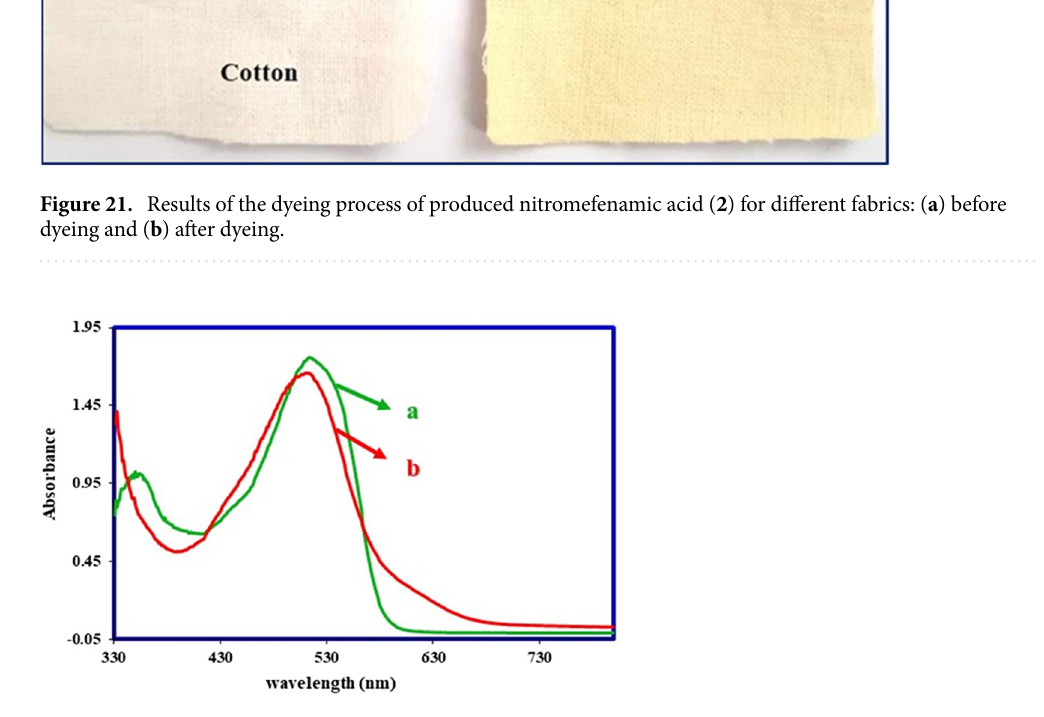
Figure 22. Ultraviolet / Visible absorption spectrum (a) Solvent Red 4 (b) a solution of mixture 1S-RED and 2S-RED in acetone; Room